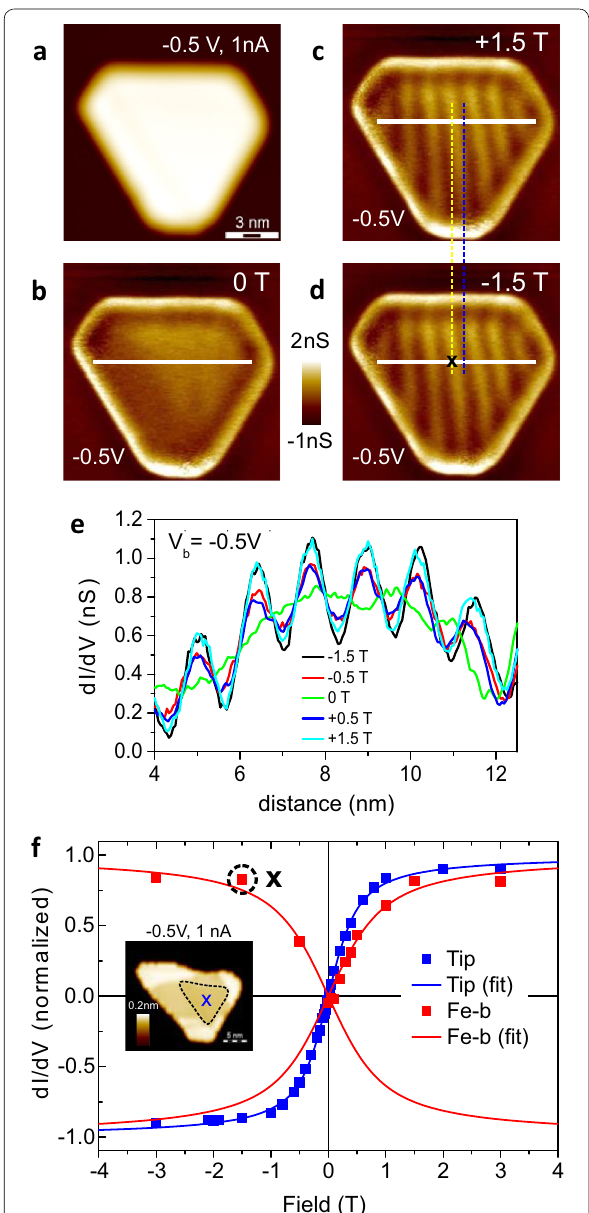
Fig. 10 Spin‑STM of thermally fluctuating magnetic order with a field‑tuned superparamagnetic tip. a – d CC‑STM ( a ) and d I /d V maps at 0 T ( b ), 1.5 T ( c ), and 1.5 T ( d ) of a bilayer bridge‑stacked Fe + − nanoisland measured with a superparamagnetic Fe‑coated W tip at 10 K. ( V b 0.5 V, I set 1 nA). e dI/dV profiles along the line = − = depicted in the CC‑STM image in a , measured at 1.5 T ( black ), 0.5 − − T ( red ), 0 ( green ), 0.5 T ( blue ), 1.5 T ( cyan ). f Field dependence + + of d I /d V contrast of the stripe pattern ( red ) measured at a bright center as marked by the cross in d . Field dependence of the d I /d V polarization. Figure 11a, b are two d I /d V images on the contrast measured at the center of the Co ( blue ) of the Fe|Co island as indicated in the inset , with the same tip as used for measuring the Fe island measured at μ 0 H 1.1 T, with (b) AP and (c) P = − island. The solid curves are fits of the data to the Langevin equation, magnetization configurations, as indicated in Fig. 5c. for the Fe ( red ) and Fe|Co ( blue ) nanoislands. All the data are normal‑ Figure 11d is the A dI/dV map, at the given bias voltage ized with the saturation values obtained from the Langevin V b , calculated from the d I /d V images in Fig. 11b and c.